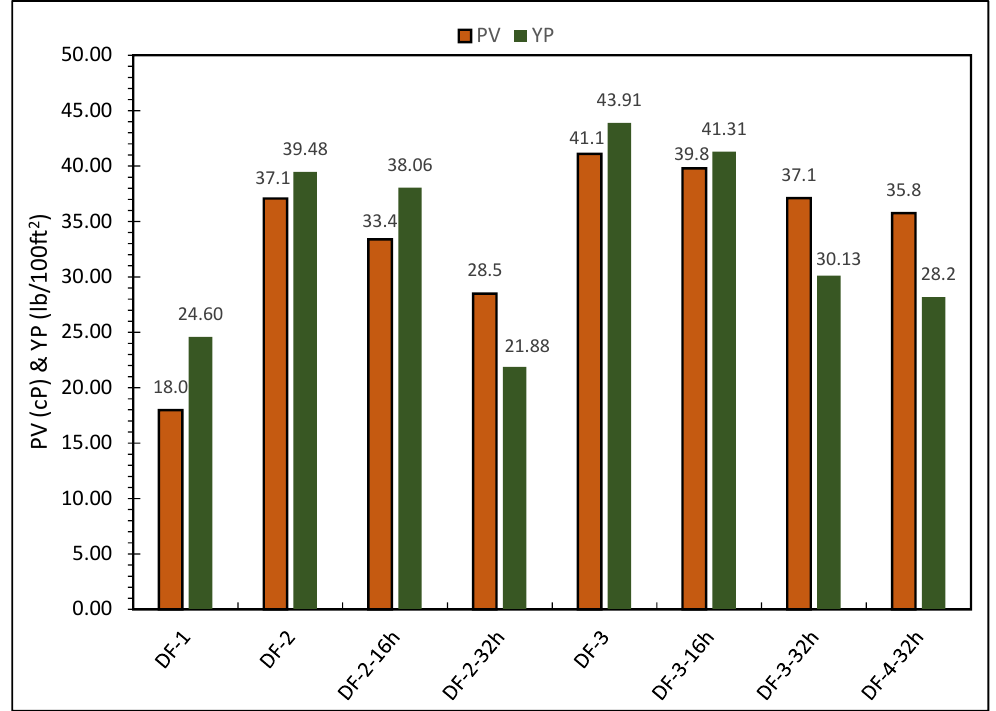
Figure 2. The plastic viscosities and yield points of the OBDFs. The ratios of yield point to plastic viscosity (YP/PV) is used to investigate the cutting suspension of drilling fluids. The drilling fluids having a ratio in the range of (0.75–1.5) shows good suspension capacity. This ratio was highest for DF-1 was 1.37 while the YP/PV ratio for DF-2 formulation was 1.06. For DF-2, after hot rolling for 16 h and 32 h, the YP/PV ratio was 1.14 and 0.77, respectively. Therefore, after 16 h of hot rolling, the YP/PV ratio slightly increased by 7.55% and resulted in better suspension capacity of the drilling fluid. On the other hand, drilling fluid formulation DF-2 lost cuttings suspension capacity after 32 h of hot rolling as the YP/PV ratio decreased to 0.77. For DF-3, the YP/PV ratio was affected by hot rolling and it was decreased with high temperature exposure. A very slight change observed after 16 h hot rolling while after 32 h, the YP/PV ratio reduced to 0.81. Therefore, DF-3 showed better carrying capacity after 32 h of hot rolling when compared to DF-2. Furthermore, DF-4 after 32 h of exposure did not bring major change in its ratio when compared to DF-3-32h. The ratios of yield point to plastic viscosity (YP/PV) for the tested drilling fluids are shown in Figure